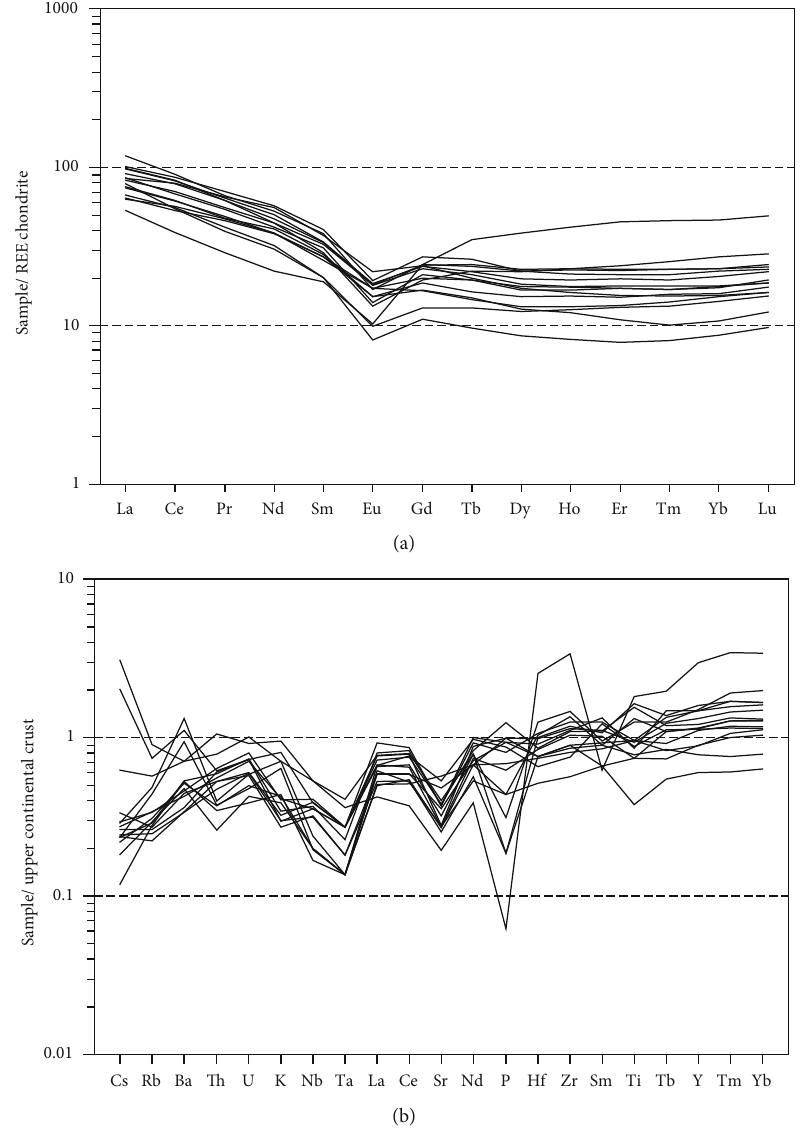
Figure 6: (a) Chondrite-normalized REE and (b) incompatible trace element patterns for sandy conglomerate samples in the Mahu Sag. Chondrite values are from [78]. Upper continental crust values are from [79].